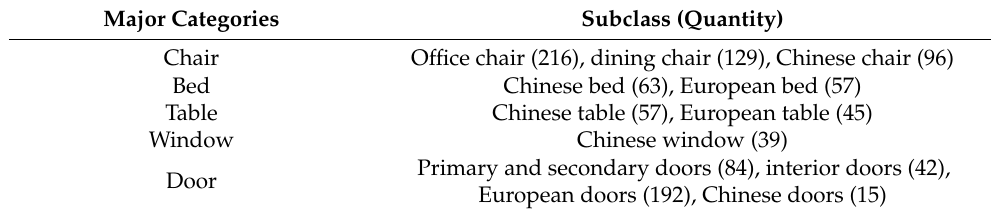
Table 2. Breakdown of the major and minor categories of the BIM family images.